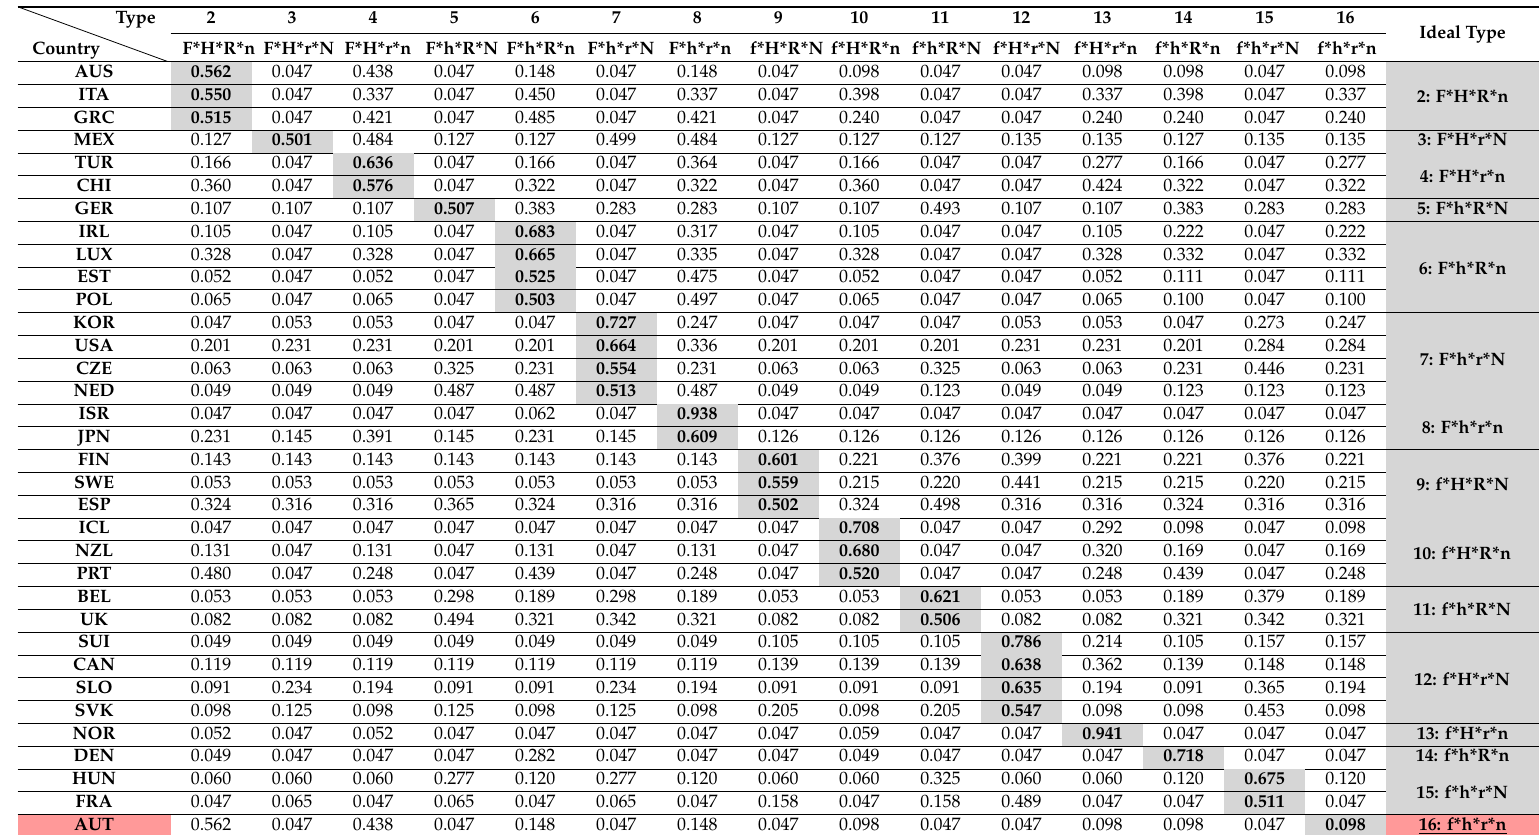
Table 5. Results of Fuzzy-set ideal type analysis by OECD countries